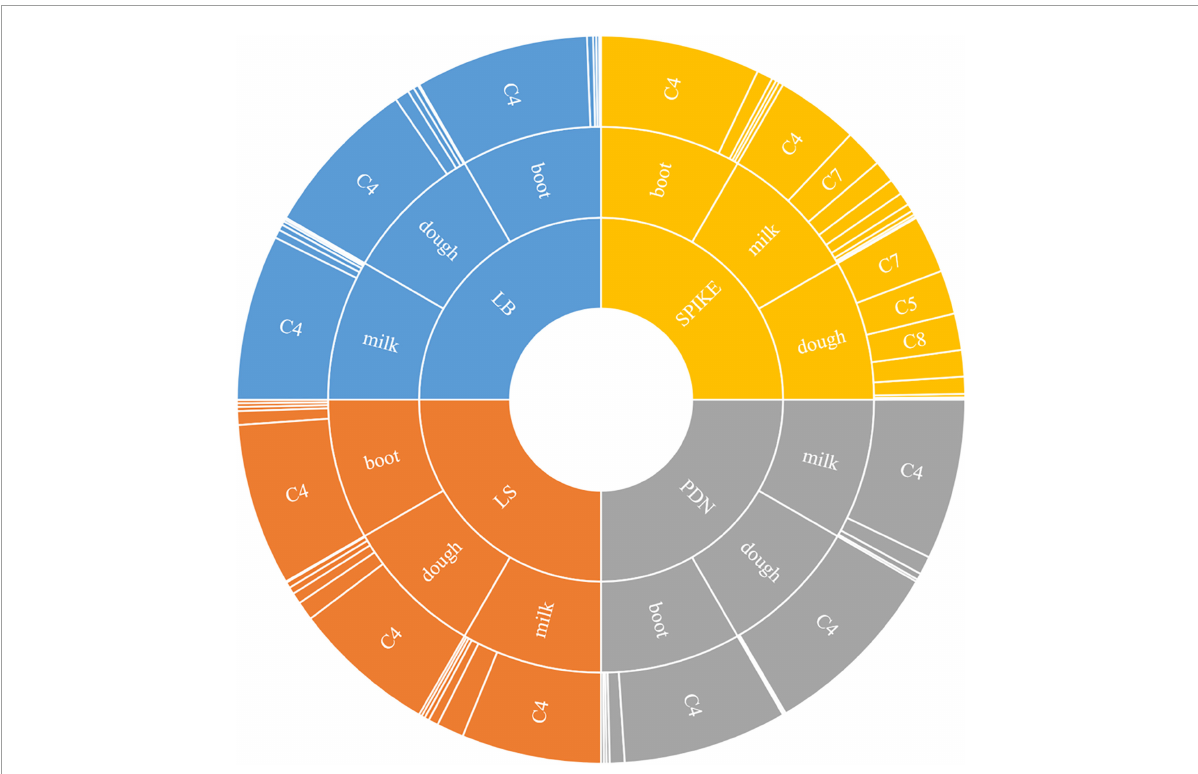
FIGURE1 Sunburst chart showing spatio-temporal changes of various components of γ -oryzanol in four different tissues (LB: leaf blades; LS: leaf sheaths; PDN: peduncle; Spike: spikelets) across three different developmental stages (Boot, Milk, and Dough). The size of the segment reflects the percentage proportion of a particular component to total γ -oryzanol. C1: 24-methylenecycloartanyl- p -coumarate; C2: (cid:49) 7-stigmastenyl ferulate; C3: stigmasteryl ferulate; C4: cycloartenyl caffeate; C5: cycloartenyl ferulate; C6: campesteryl caffeate; C7: 24-methylenecycloartanyl ferulate; C8: campesteryl ferulate; C9: β -sitosteryl